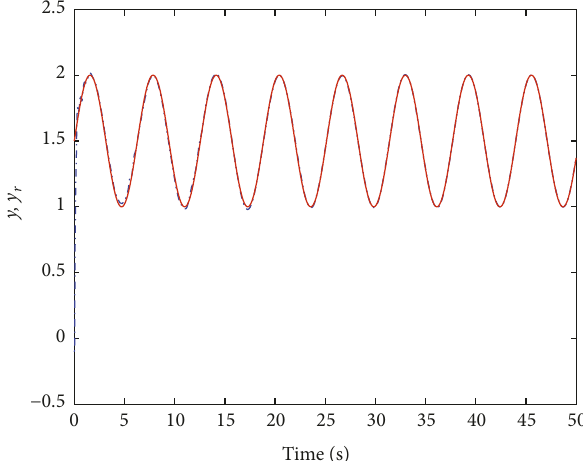
Figure 6: Trajectory of tracking error 𝑒 1 (𝑡) using method [42].